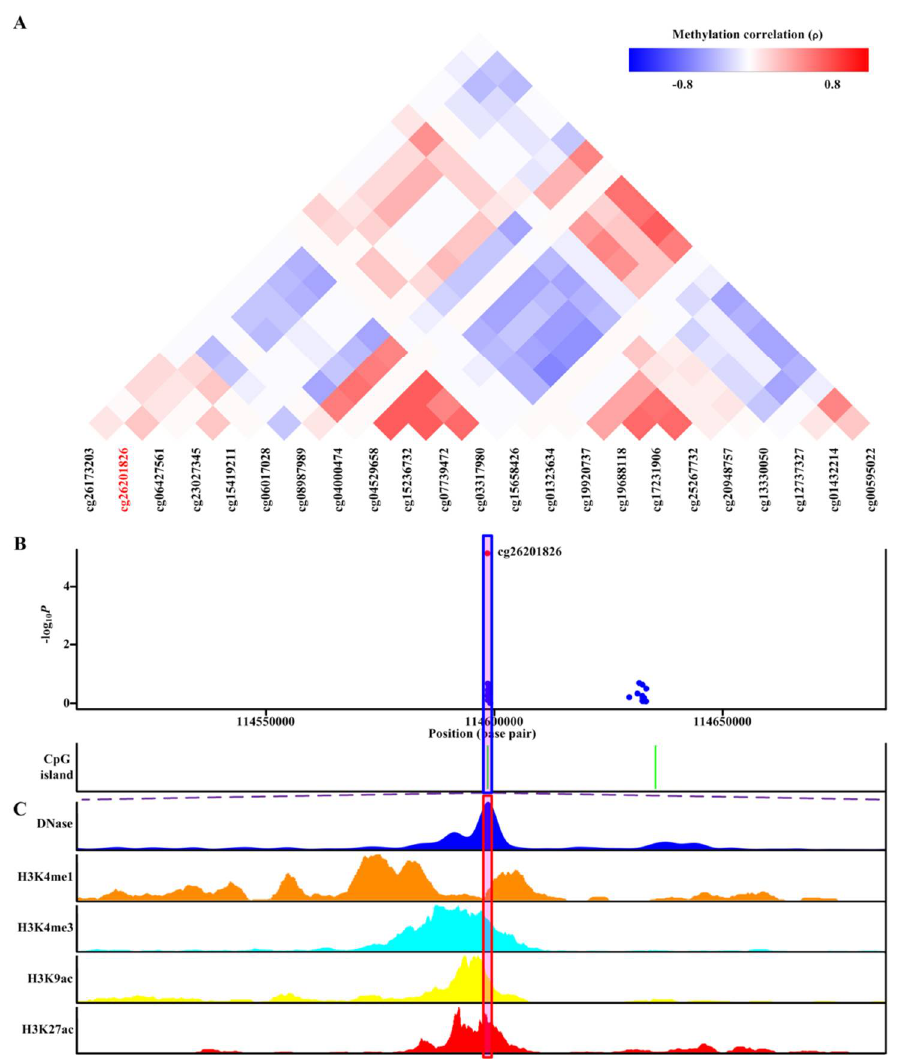
Figure 4. Co-methylation analysis and functional localization of cg26201826 ( PGGT1B ). ( A ) Patterns of co-methylation at the CpG sites surrounding cg26201826. ( B ) Regional association results along with position of nearby CpG islands (green). cg26201826 (highlighted in shaded box) is located in CpG islands. ( C ) Functional annotation of cg26201826. DNase hypersensitive sites derived by DNase-seq (DNase Track) and histone marks surrounding cg26201826 (H3K4me1, H3K4me3, H3K9ac, and H3K27ac tracks) in monocytes are shown. DNase hypersensitivity, H3K4me1, H3K4me3, H3K9ac, and H3K27ac histone marks are associated with active regulatory elements.